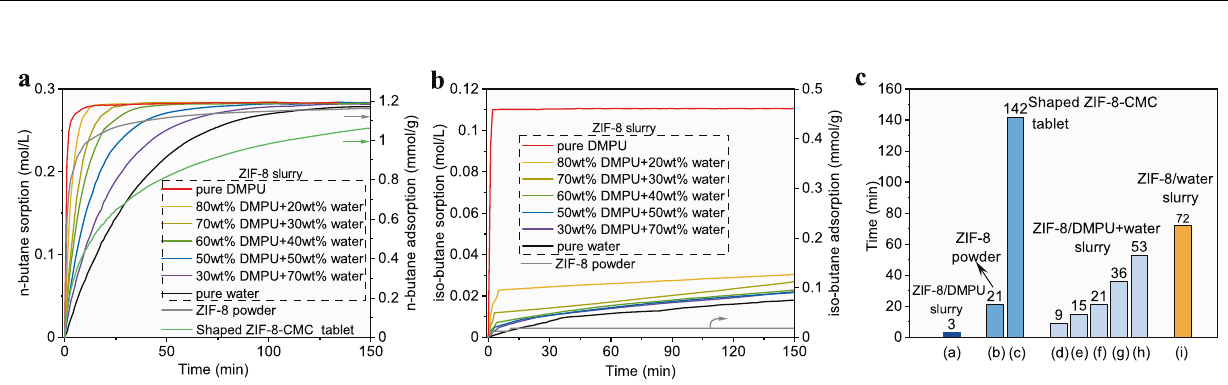
Fig. 3 | Comparison ofthe single-component sorption speed ofsolid ZIF-8 and ZIF-8 slurries. Kinetic pro fi les of n-butane ( a ) and isobutane ( b ) in ZIF-8 slurries (left axis) and ZIF-8 powder, shaped ZIF-8 (right axis), where temperature, initial gas-slurryvolumeratio,initialgas – solidvolumeratioandsolidZIF-8contentinthe